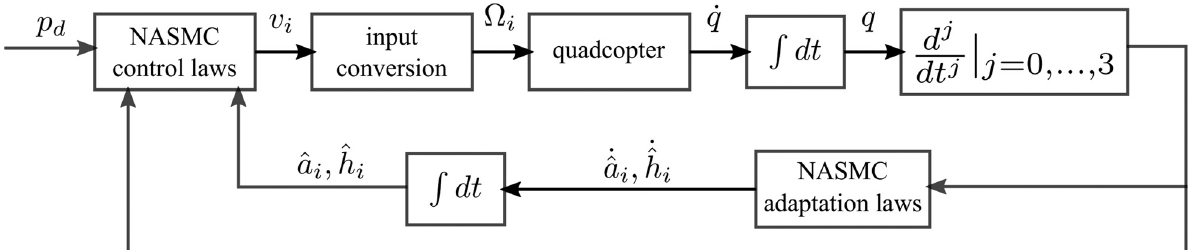
Figure 4: Control structure block diagram of quadcopter